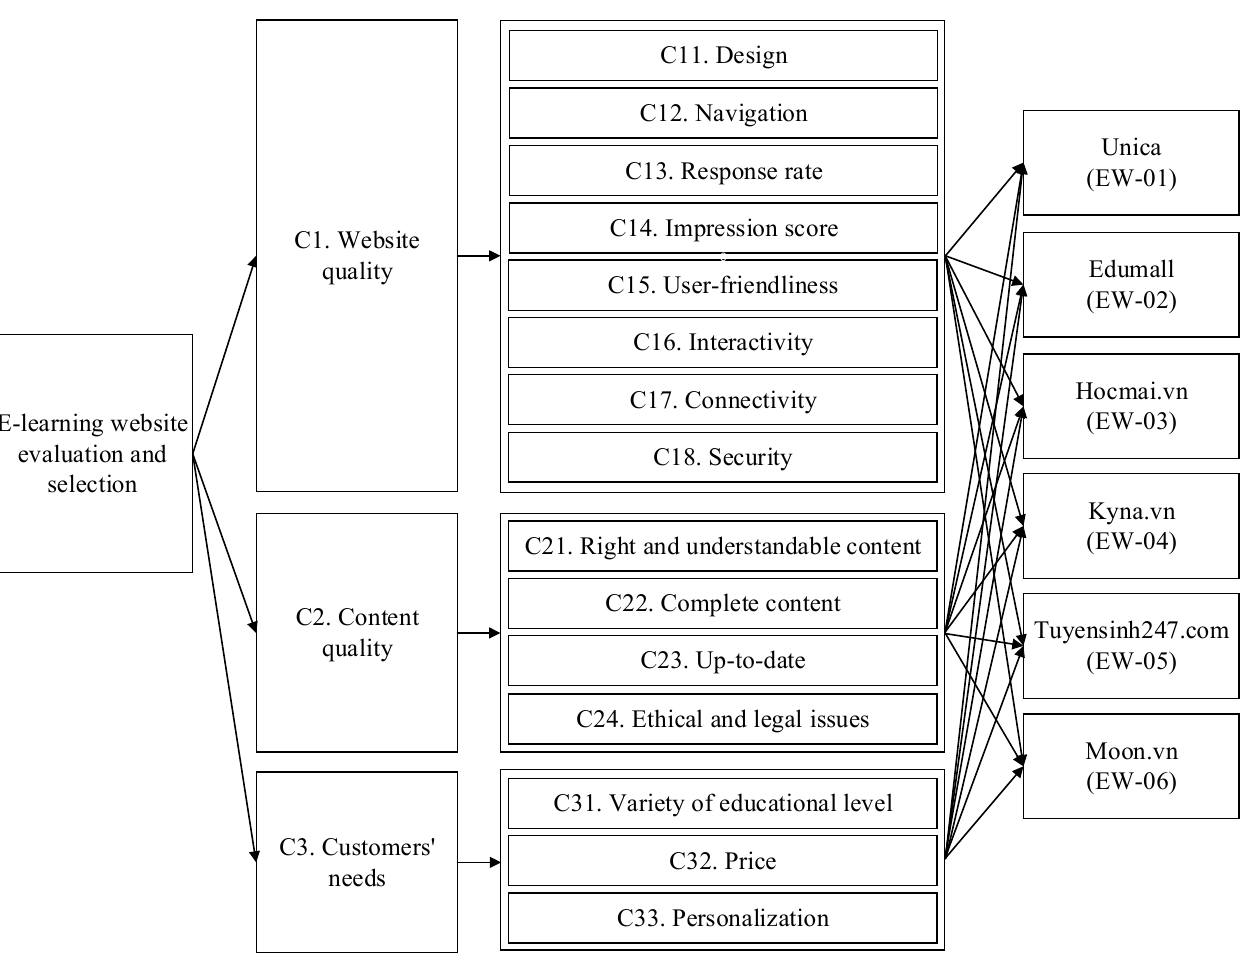
Table 10. The values of the grey positive and negative ideal solutions from the G-TOPSIS model.